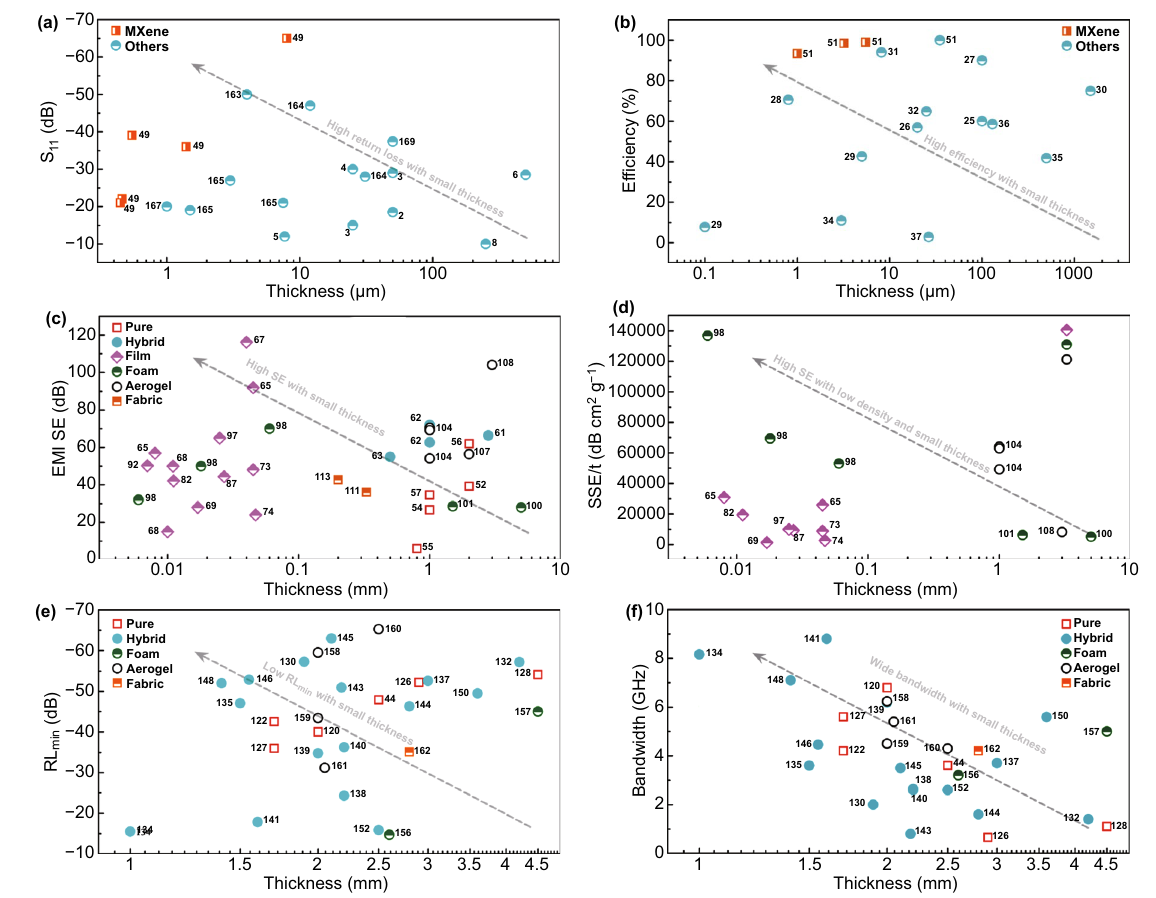
Fig. 12 Comparison of a the return loss and b efficiency of MXene antenna with other materials. c EMI SE and d SEE t versus thickness for MXene‑based shielding materials. e RL min and f absorption bandwidth versus thickness of typical MXene‑based absorbing